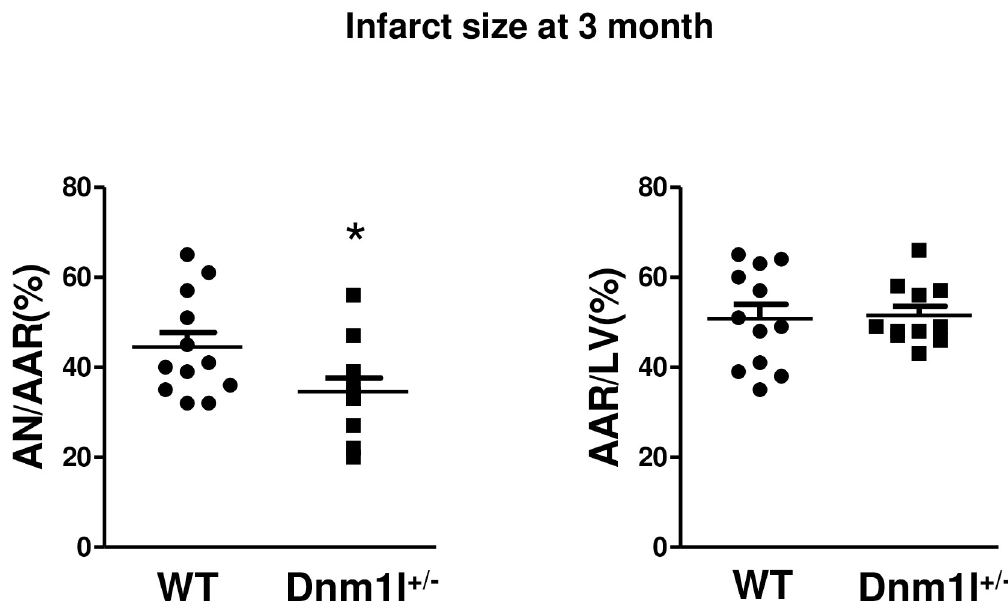
Fig 2. Histograms showing area necrosis (AN) as a percentage of area at risk (AAR) or AAR as a percentage of the total left ventricle (LV) area (n = 11-12/group) � p < 0.05. both group WT (0.09 ± 0.01 at baseline vs . 0.43 ± 0.05 after I/R p < 0.001) and Dnm1l +/- mice (0.07 ± 0.01 at baseline vs . 0.96 ± 0.16 after IR p < 0.001). This increase was significantly higher in Dnm1l +/- mice (p < 0,001) than in WT (p < 0,01). P62 protein level was significantly increased after I/R in the Dnm1l +/- mice only (0.25 ± 0.02 at baseline vs . 0.36 ± 0.05 after IR p = 0.038).